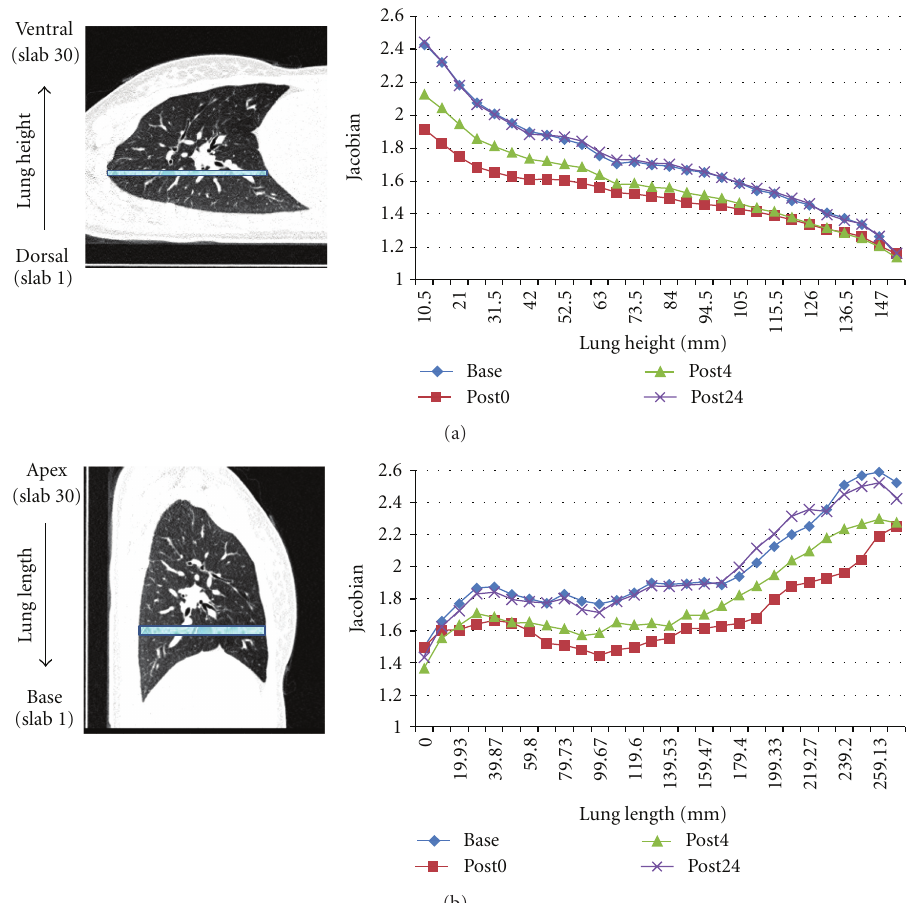
Figure 11: Lung expansion pattern within each phase for one subject. (a) shows the slab division scheme from dorsal to ventral lung, and the corresponding mean Jacobian in each slab over four phases. (b) shows the slab division scheme from apex to base lung, and the corresponding mean Jacobian in each slab over four